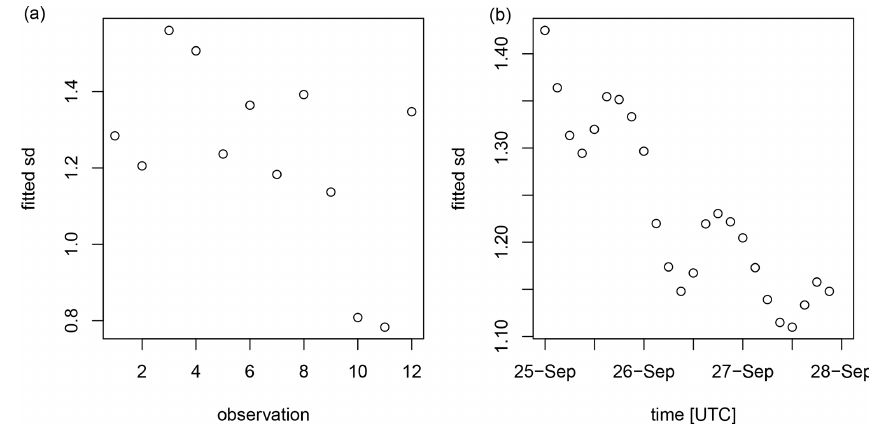
Figure 6. The standard deviation obtained after fitting a Gaussian distribution to the SRS ensemble. (a) Standard deviation fitted for each of the 12 observations (all release time intervals are aggregated); the indices of the observations on the x axis are arbitrary. (b) Standard deviation fitted for each of the 24 release time intervals (all observations are aggregated); each release time interval is 3h long.